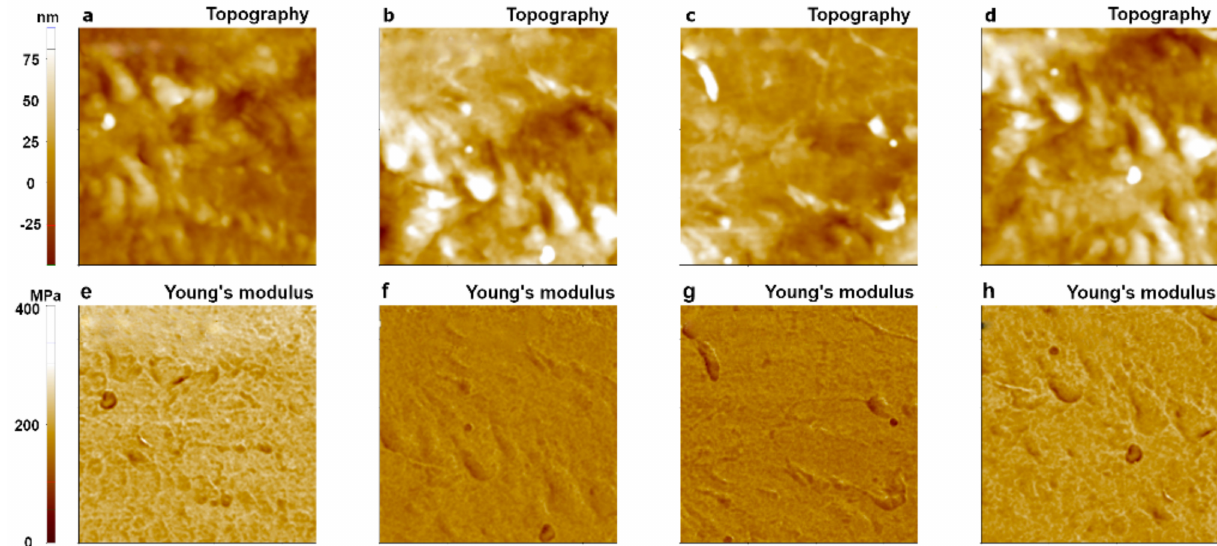
Figure 11. Topography and Young’s modulus images of LDPE obtained with an SD-R30-FM cantilever (tip radius: 30 nm) using the PinPoint TM nanomechanical mode of AFM. The 1st image ( a , e ); 10th image ( b , f ); 100th image ( c , g ); and 200th image ( d , h ). The size of all images was 10 µ m × 10 µ m.